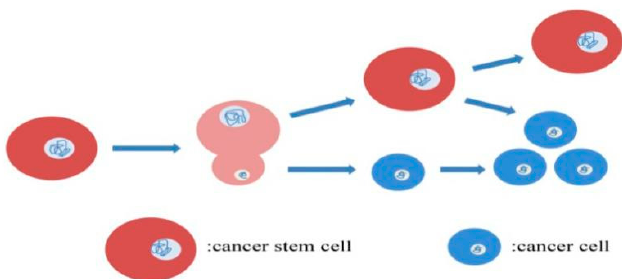
Figure 1. Asymmetric mitotic division pattern of CSCs.